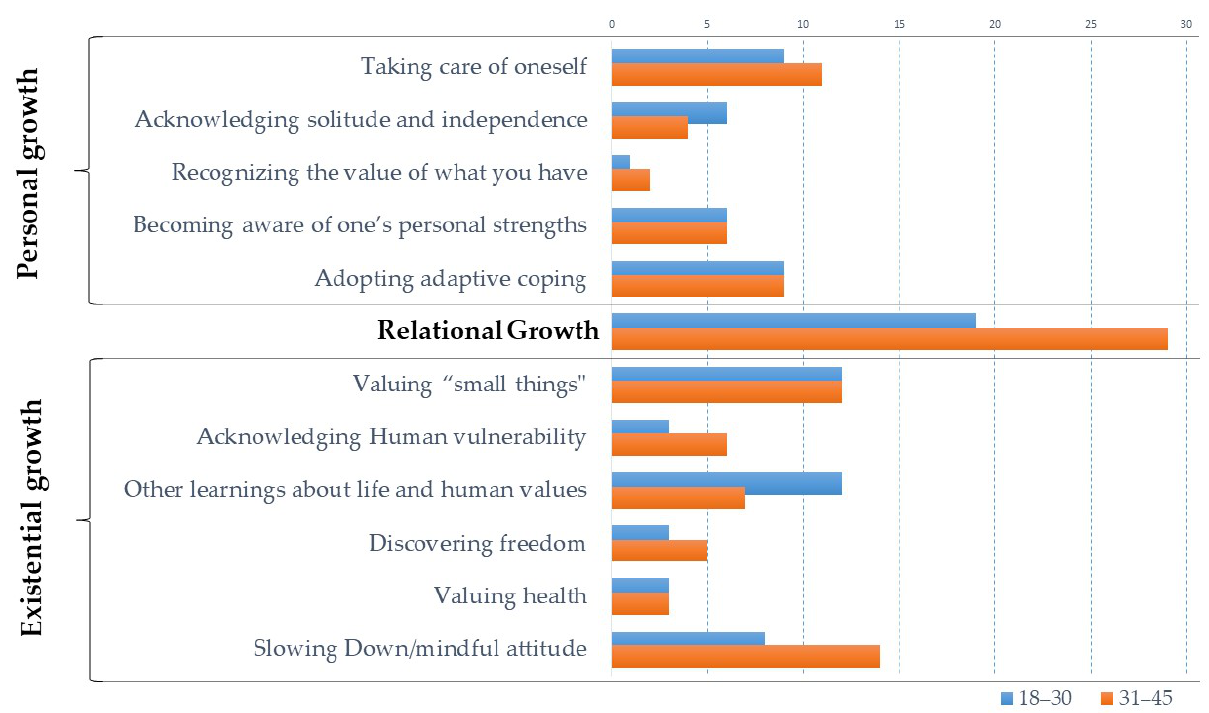
Figure 1. Frequencies of quotes by the two age subgroups (i.e., 18–30;